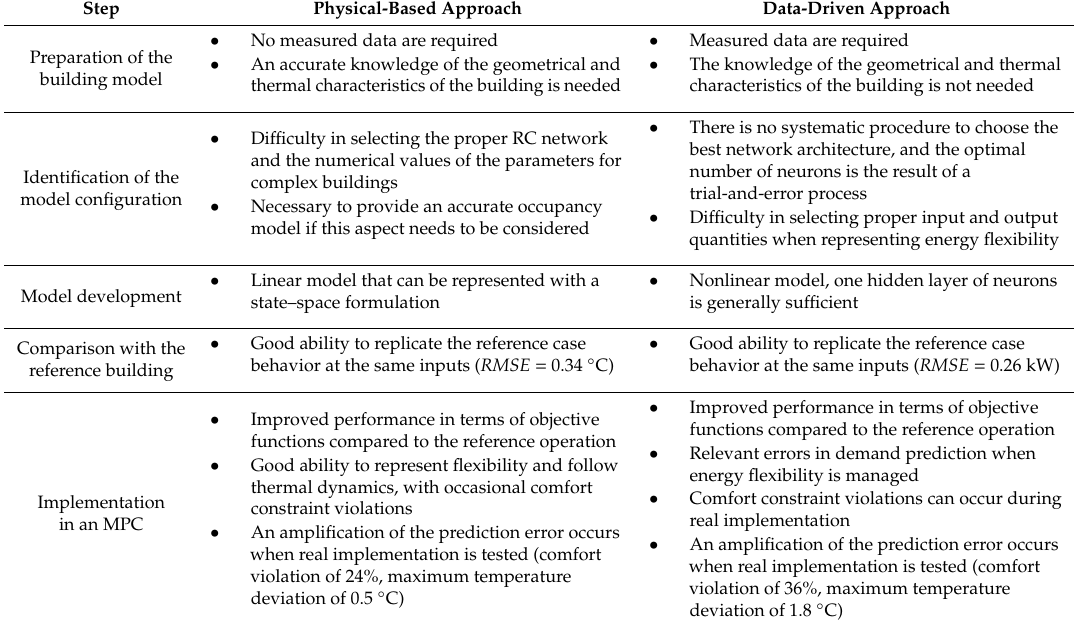
Table 2. Comparison summary between a physical-based and a data-driven approach in an operative